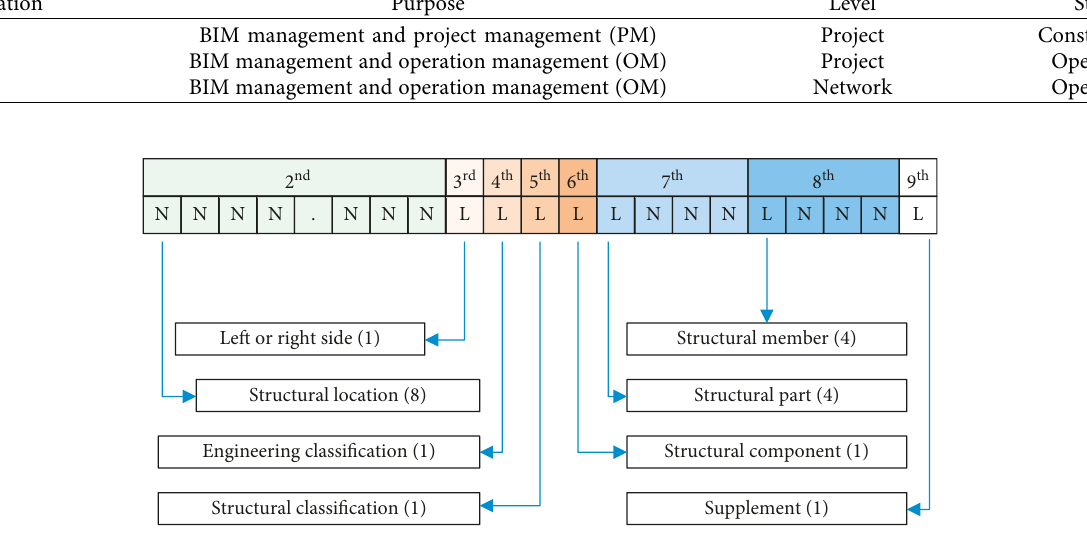
Figure 1: The basic flowchart for EBS coding of standards. Top row 2nd–9th districts are labelled according to letter or number. L refers to abbreviation of “letter” (from A to Z). N refers to abbreviation of “number” (from 0 to 9). The description of breakdown of structure components: structural location, left or right side, engineering classification, and characteristics pertaining to